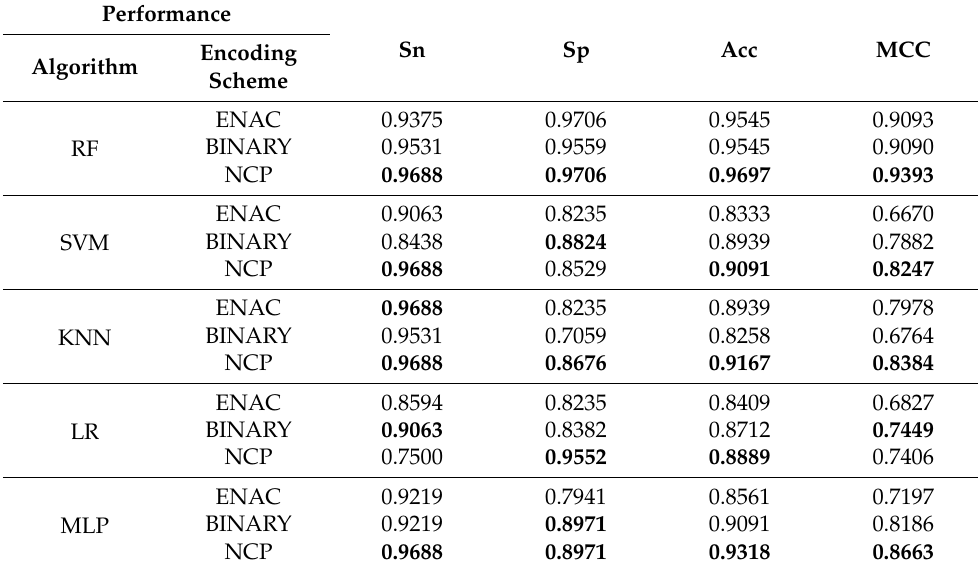
Table 3. Performance of different classifiers with ENAC, BINARY, and